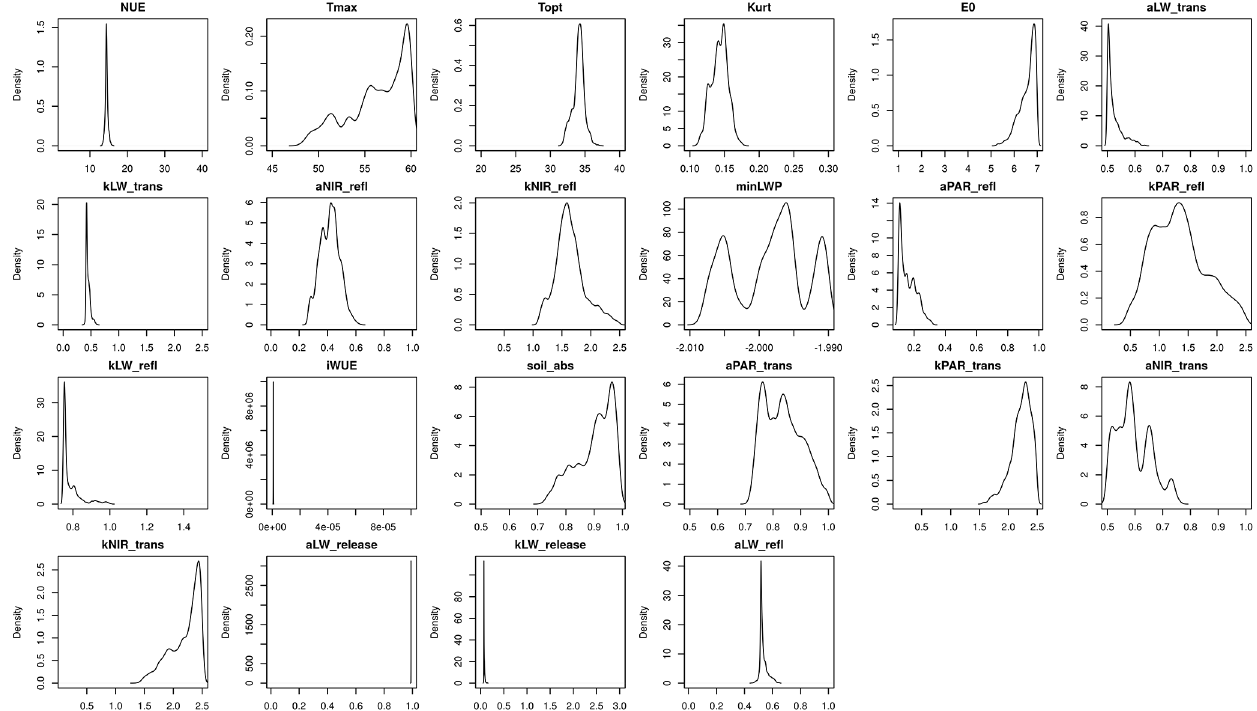
Figure A1. Probability density functions of the retrieved parameters for ACM-GPP-ET. The figure label refers to the name given in Table 2 of the main text. The range of the x axis matches that of the parameter prior ranges to allow easy identification of those parameters which are the easiest to